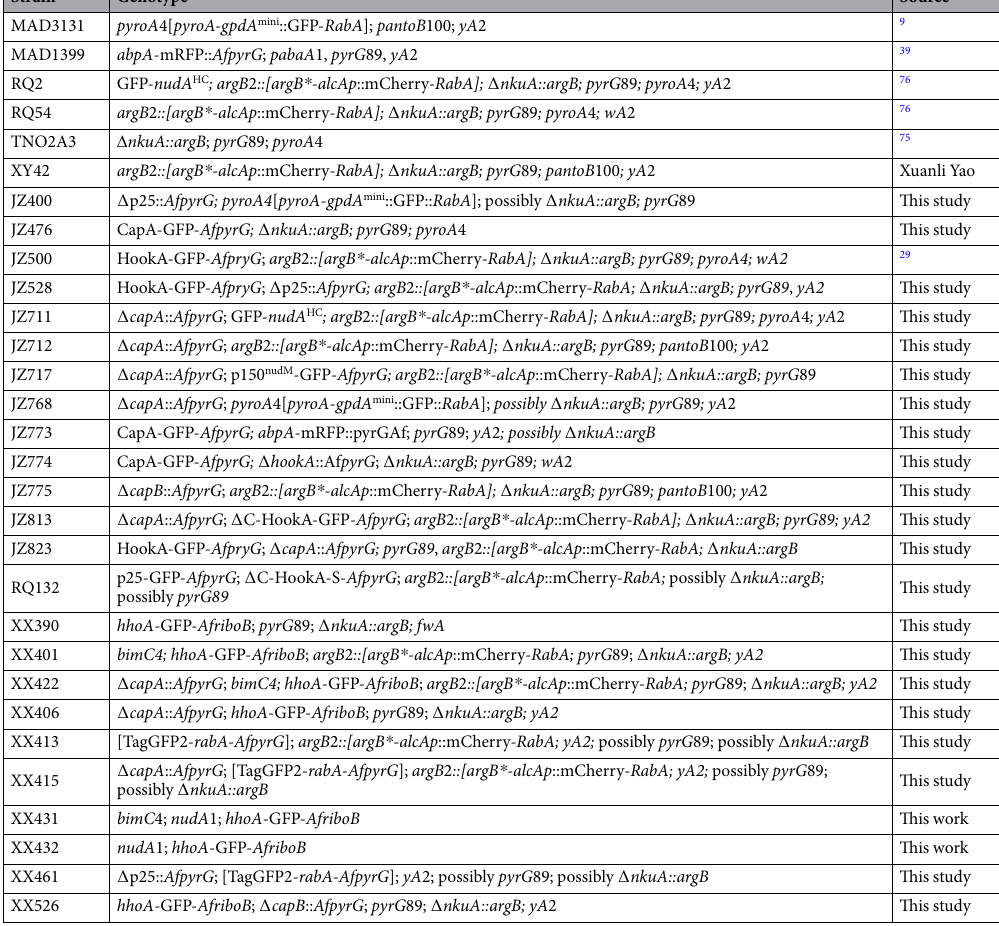
Table 2. A . nidulans strains used in this